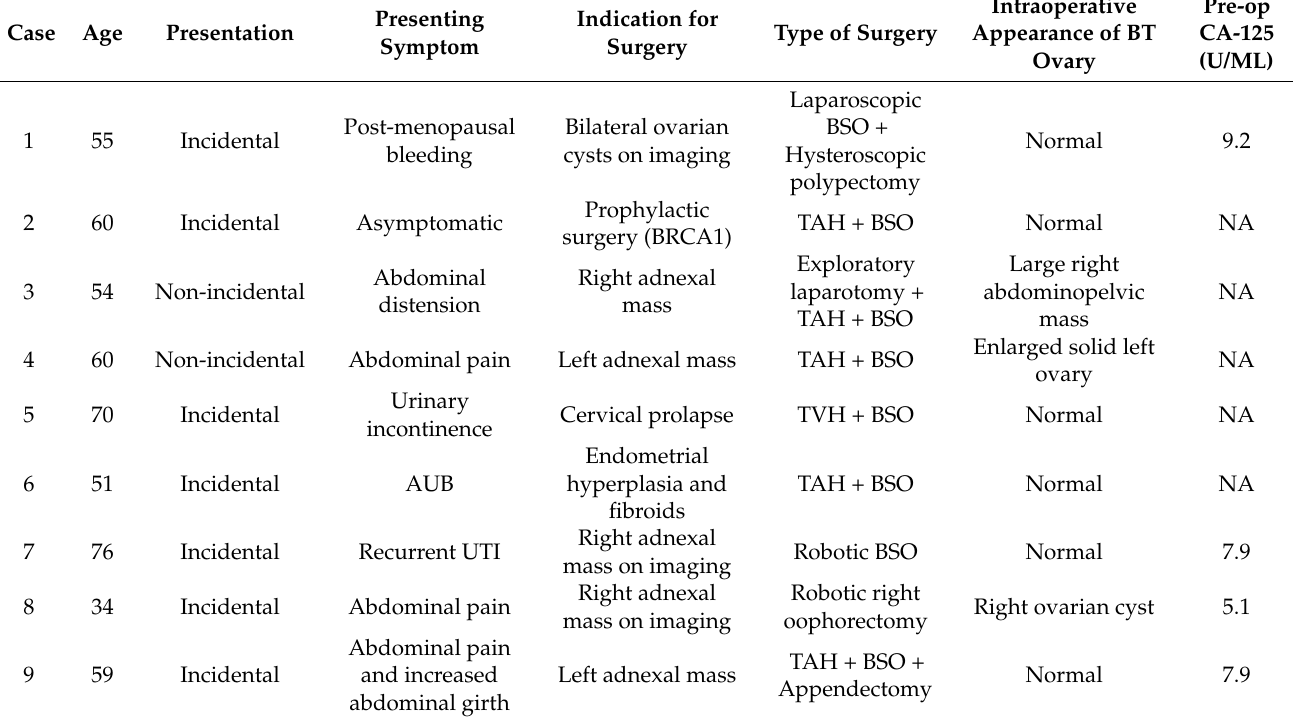
Table 1. Clinical characteristics of all Brenner tumor patients included in our study.